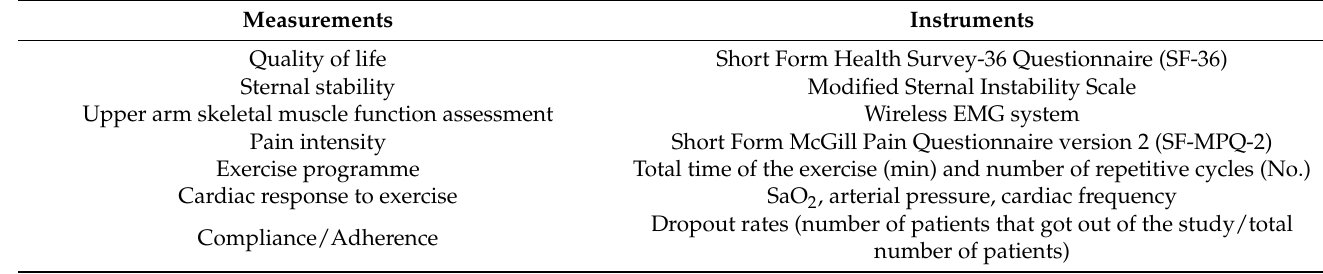
Table 3. Schedule of outcome